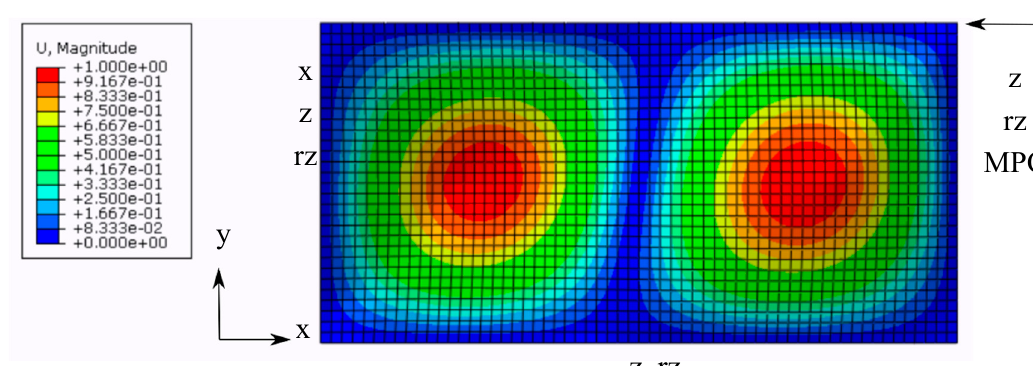
Figure 1. Boundary constraints for the buckling analysis.